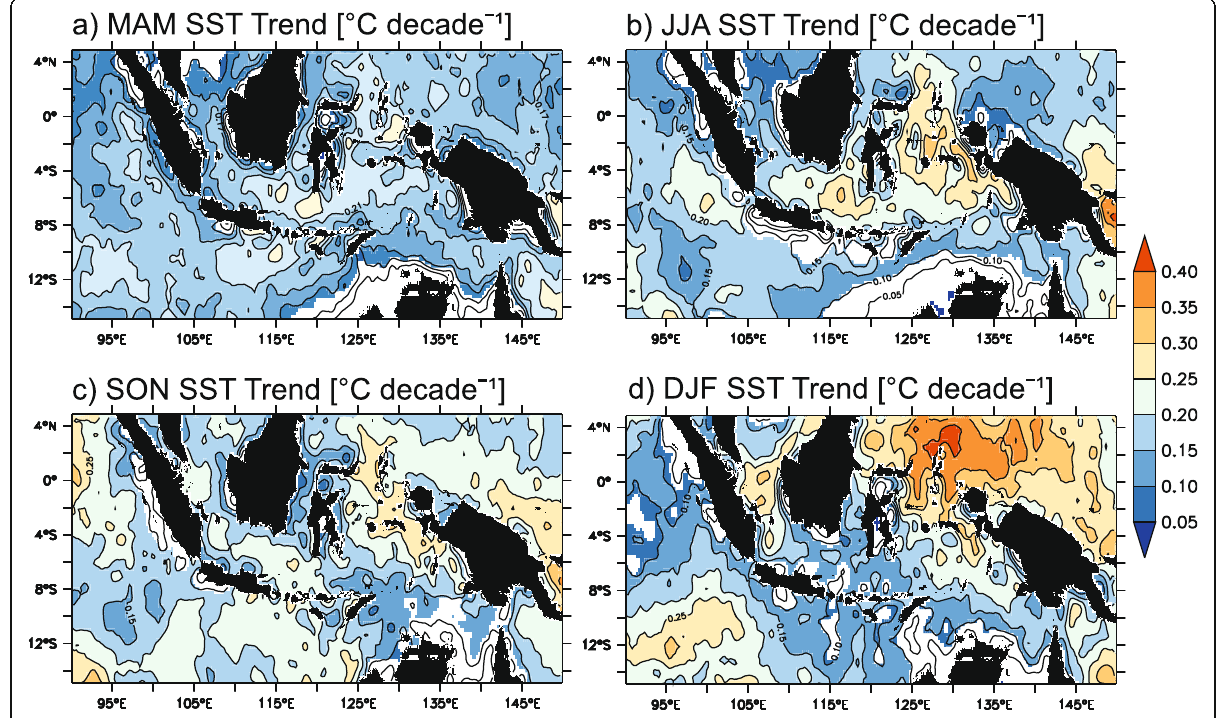
Fig. 2 Same as in Fig. 1a except for the boreal a spring, b summer, c autumn, and d winter seasons (°C/decade). Only values above 95% confidence level are